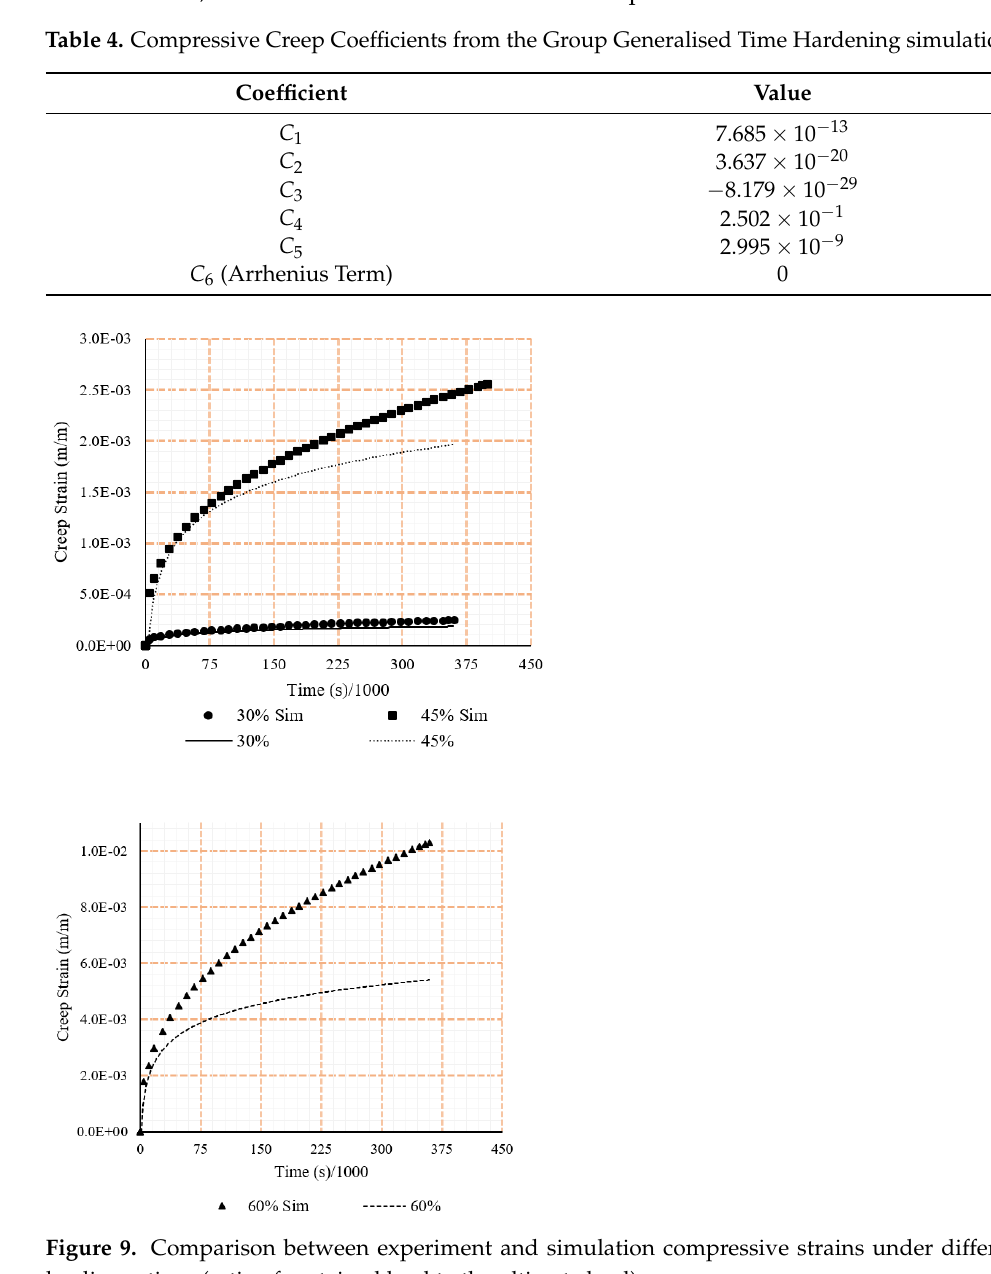
Table 4. Compressive Creep Coefficients from the Group Generalised Time Hardening simula- tions.